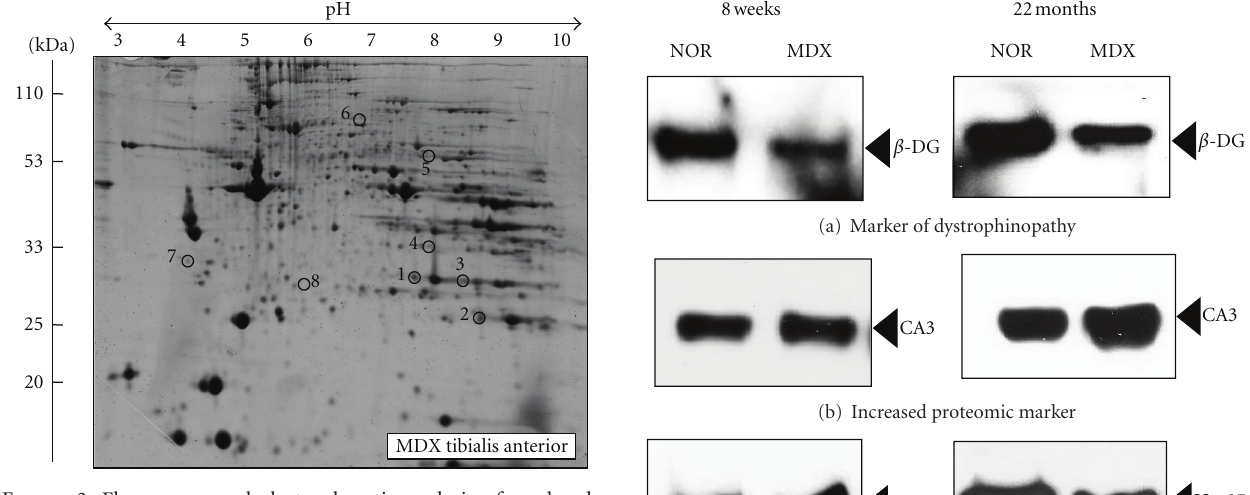
Figure 3: Fluorescence gel electrophoretic analysis of aged mdx tibialis anterior muscle. Shown is a representative RuBPs-labelled master gel of crude tissue extracts from mdx tibialis anterior muscle. Protein spots with an age-related change in expression levels are marked by circles and are numbered 1 to 8. See Table 2 for the mass spectrometric identification of individual muscle-associated proteins. The pH values of the first dimension gel system and molecular mass standards of the second dimension are indicated on the top and on the left of the panels, respectively.